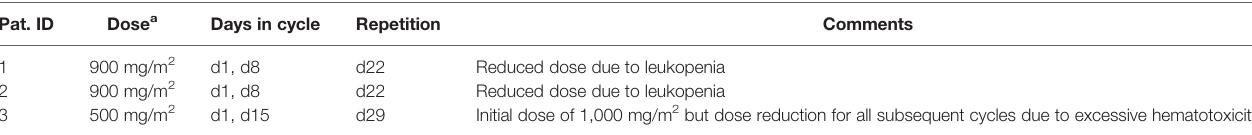
TABLE 1 | Gemcitabine maintenance therapy regimen. Pat.